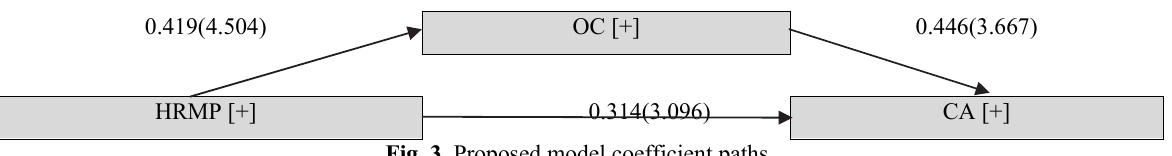
Fig. 3. Proposed model coefficient paths